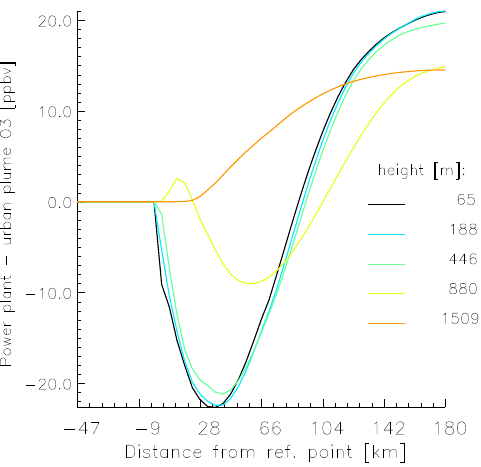
Fig. 19. Simulated absolute difference between the “power plant” and “urban area” plume OH concentrations for the five CBL model levels as a function of the distance downwind of the eastern city limits of